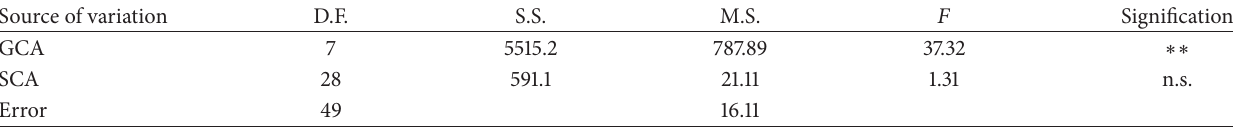
Table 6: Analysis of variance of combining ability of F2 at seedling stage. Source of variation